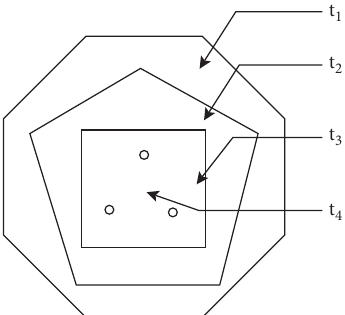
Figure 3: A functional model for feasible domain delineation.